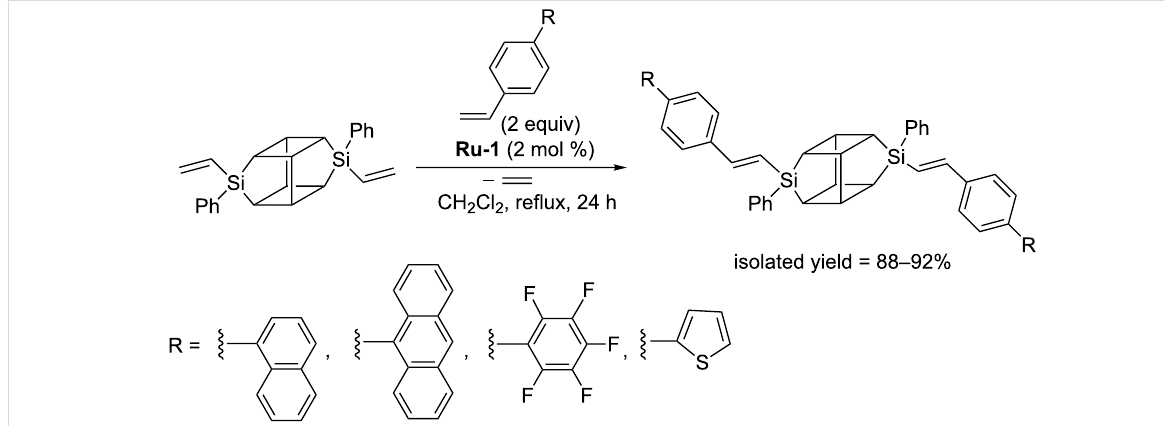
Scheme 12: Cross metathesis of DDSQ-2SiVi with substituted styrenes.